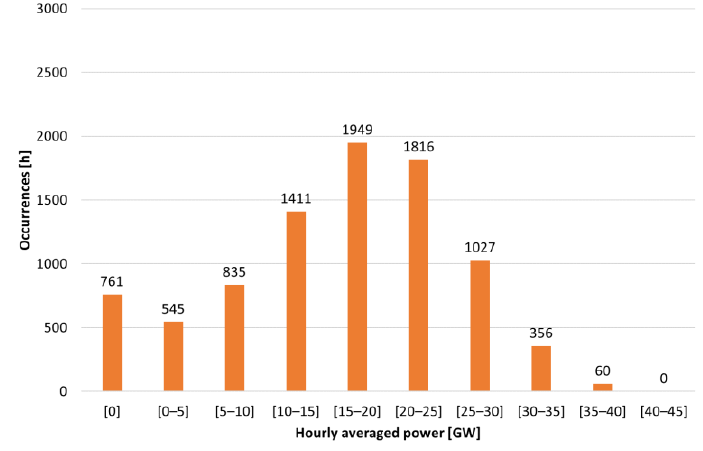
Figure 10. Distribution of hourly averaged power of non-renewable sources during the reference year in Case 1.